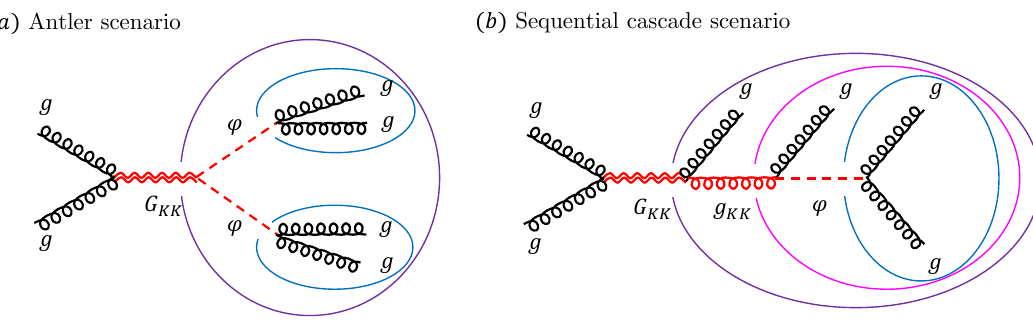
Figure 2 . Two possible event topologies arising at the LHC from KK graviton production/decay that we study in the extended warped model under consideration. Final-state gluons forming KK graviton G KK , KK gluon g KK , and radion ϕ are grouped by purple, pink, and blue circles, respec-